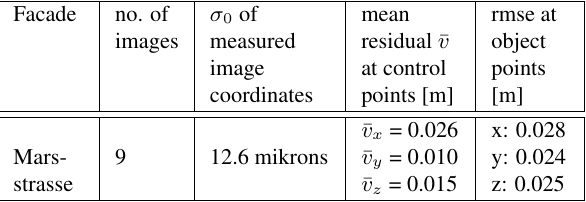
Table 1: Results of the bundle block adjustment for the facade